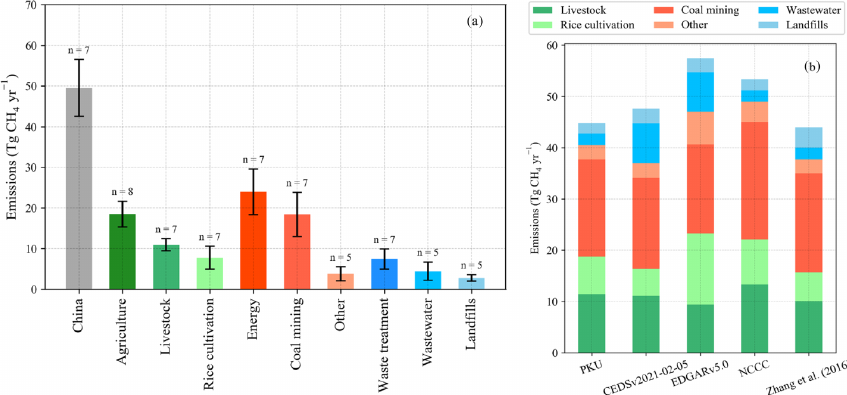
Figure 6. The mean (bar plot in a ) and standard deviation (error bar in a ) of sector and subsector CH 4 emissions and total anthropogenic CH 4 emissions by subsector (b) among different inventories in 2010.